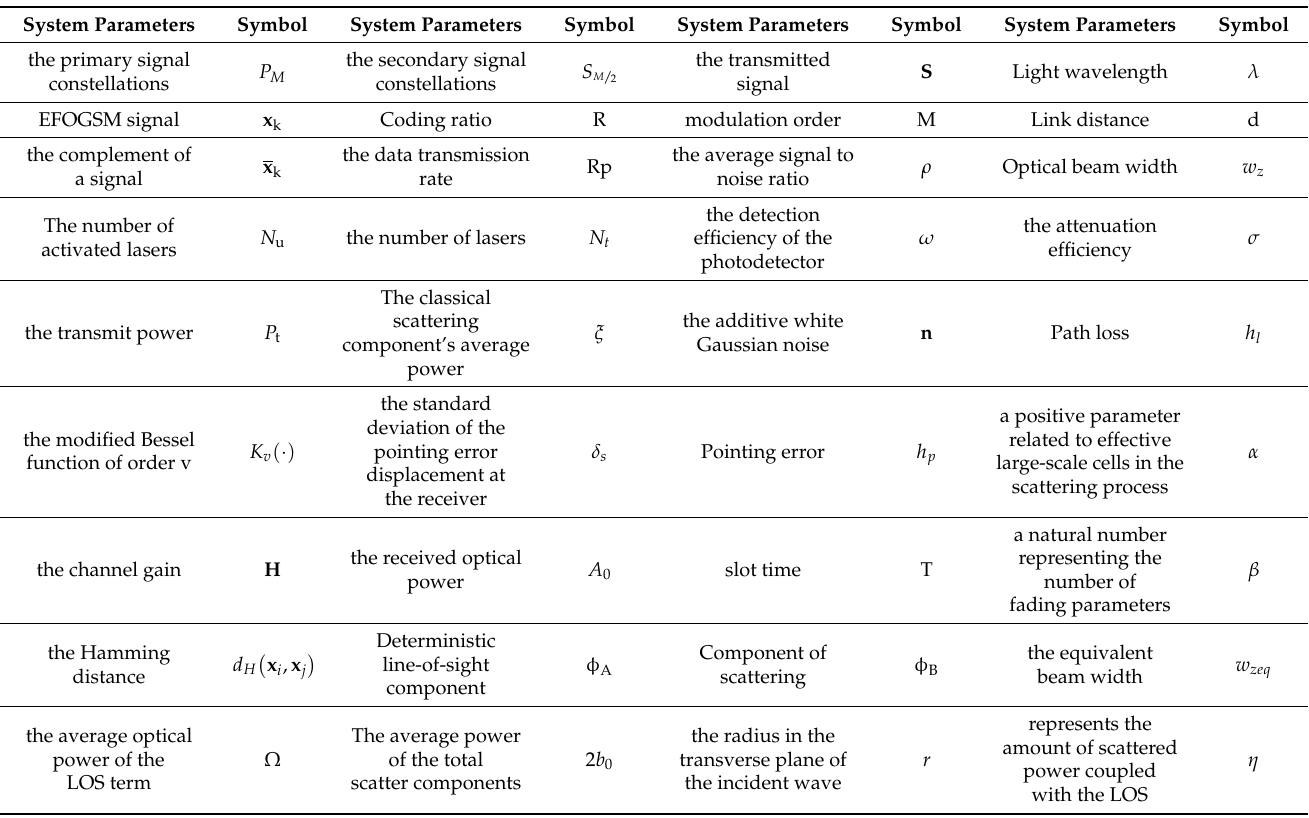
Table 4. Parameter